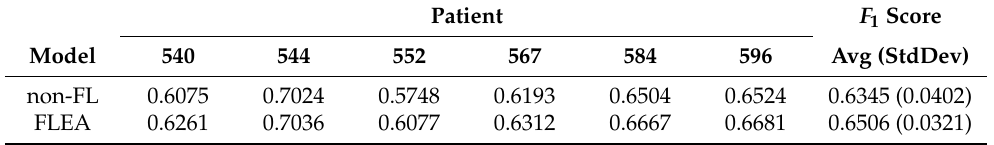
Table 7. Results obtained by the two global models over the testing sets of six new subjects.